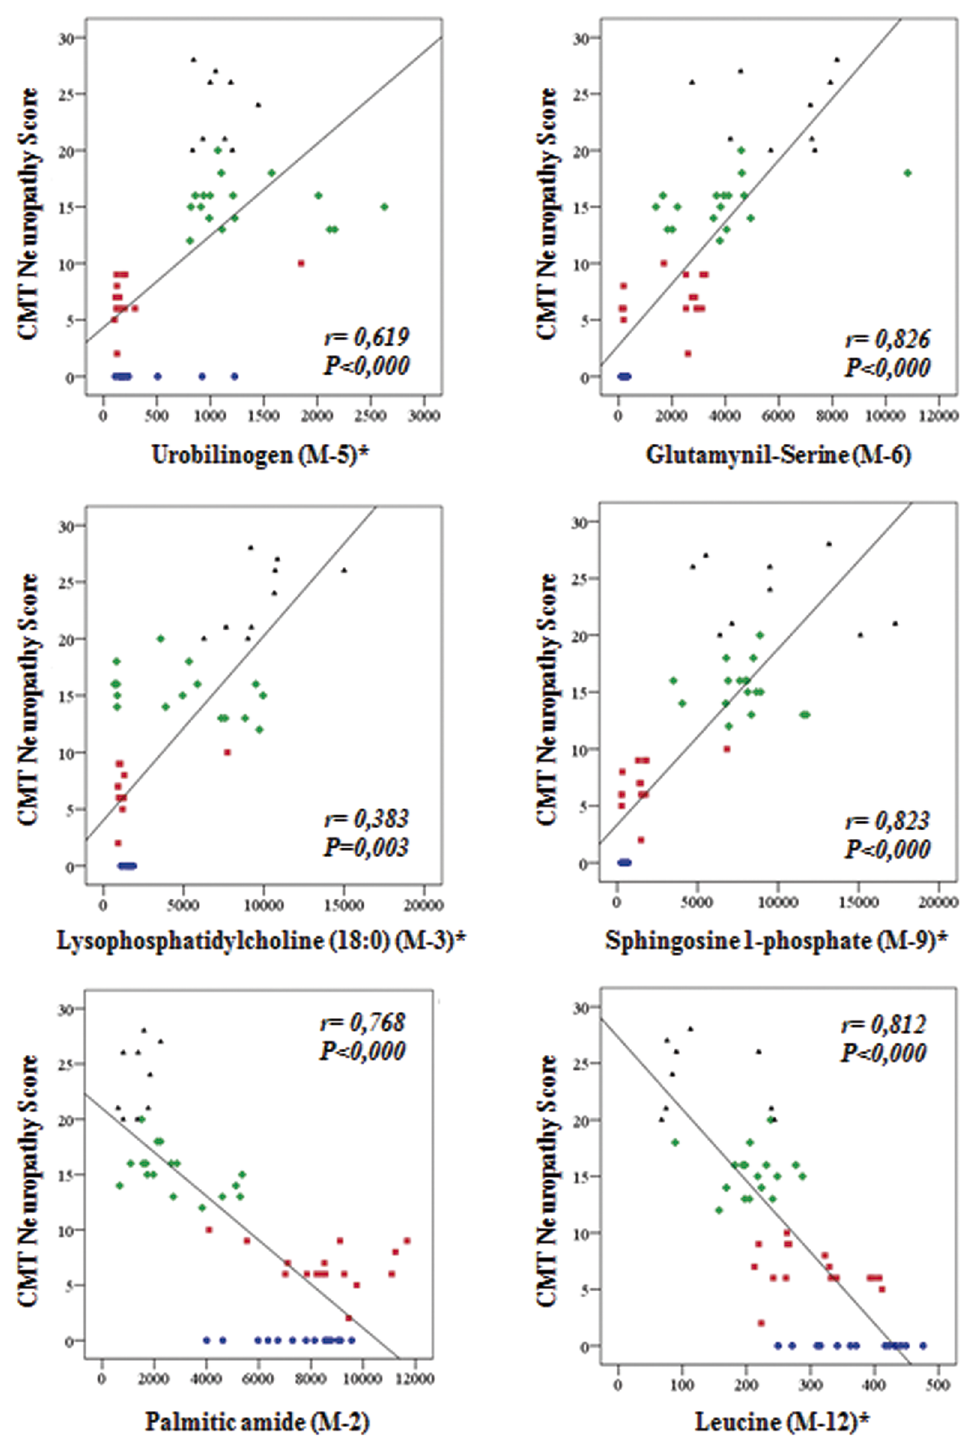
Fig 4. Scatter plots showing significant correlations between plasma metabolite levels and severity of the disease in CMT1A patients. Determination of the plasma levels of the metabolites was carried out by UHPLC-MSand its levels correlatedwith severity of the diseaseas assessedby CMTNSv2. Healthy controls (blue circles, n = 15), Mild (red squares, n = 15), Moderate (green diamonds, n = 18) and Severe (black triangles, n = 9) groupsof CMT1A patients are represented.Metabolites related to (i) protein catabolism(upper row); (ii) mobilization of membranelipids (middle row) and (iii) muscle biogenesis and the anti-apoptotic function (lower row) are represented.P-value is calculatedby analysisof variance;r is the Spearman